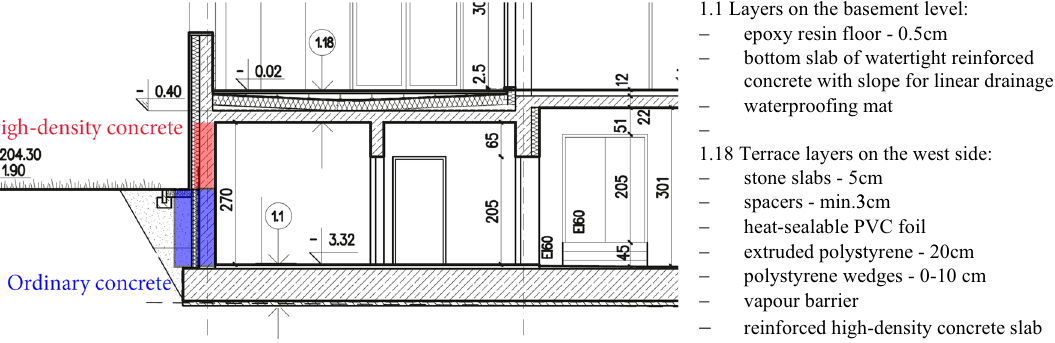
Figure 4: Variant solution of the